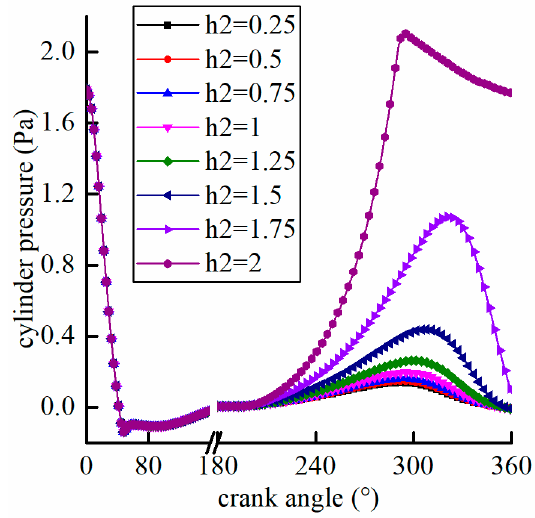
Figure 6. Cylinder pressure at different backflow clearances.